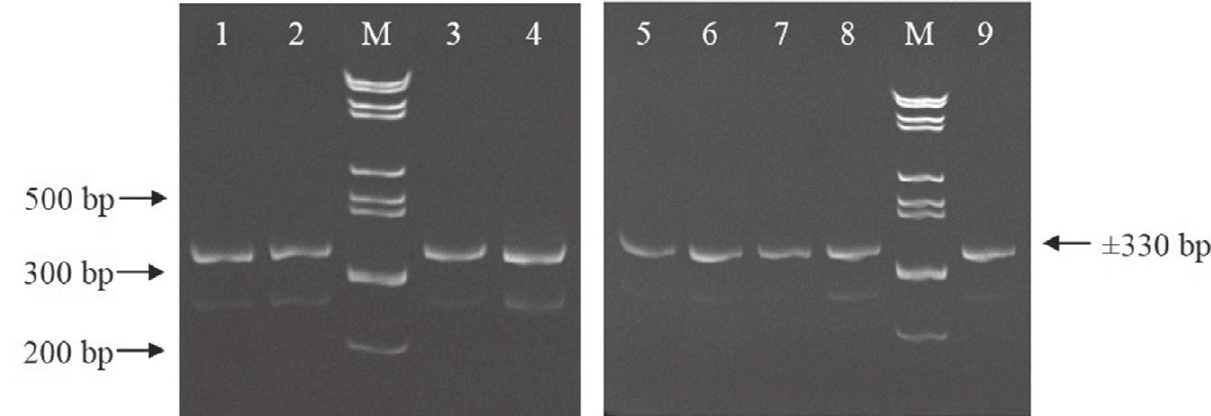
Figure 3. DNA amplification products from pepper cultivars ( Capsicum annuum ), using SCAR linked to the N gene. Band 1, ‘Cláudio’; 2, ‘Celta’; 3, ‘Amarelo’; 4, ‘Yolo Wonder’; 5, ‘Tauro’; 6, ‘Solero’; 7, ‘Vermelho’; 8, ‘Rialto’; 9, ‘Torpedo’; M, DNA marker (HyperLadder IV,